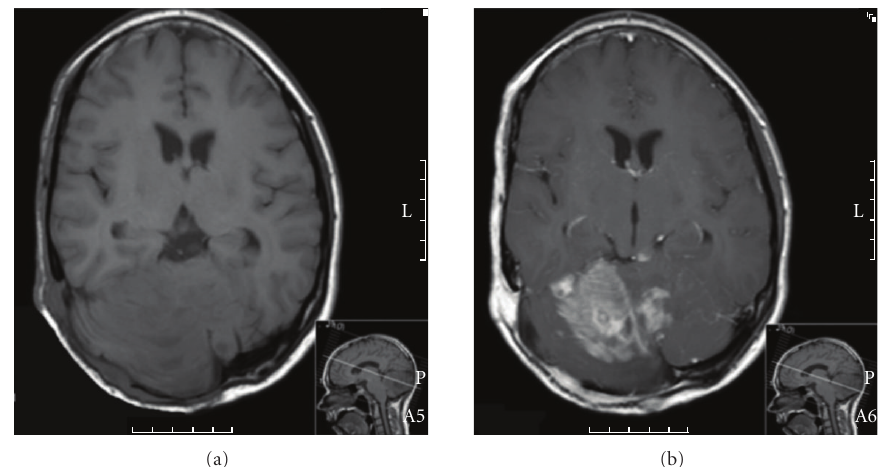
Figure 1: T1-weighted axial MRI-scan of the brain. T1-weighted axial MRI showed a (sub)occipital right-sided bone defect and a lesion in the right cerebellar hemisphere (a) that enhanced after i.v. Gadolinium administration